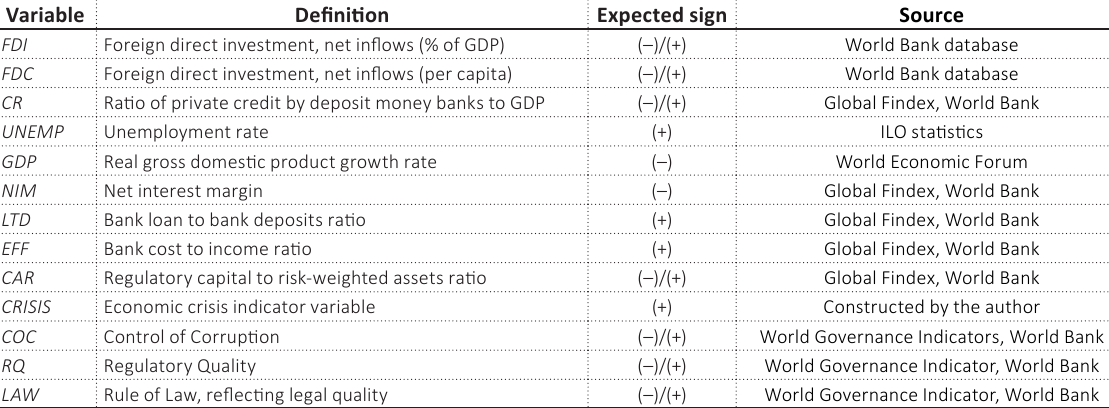
Table 1. Definitions of variables and expected